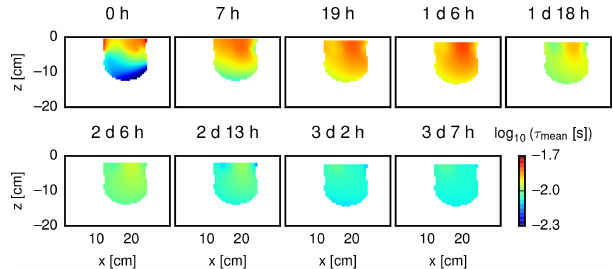
mean , for selected time steps. Only pixels belonging to the root system zone are plotted. Masked (white) pixels were classified as water. The top boundary is adjusted according to the estimated water table for each measurement time.